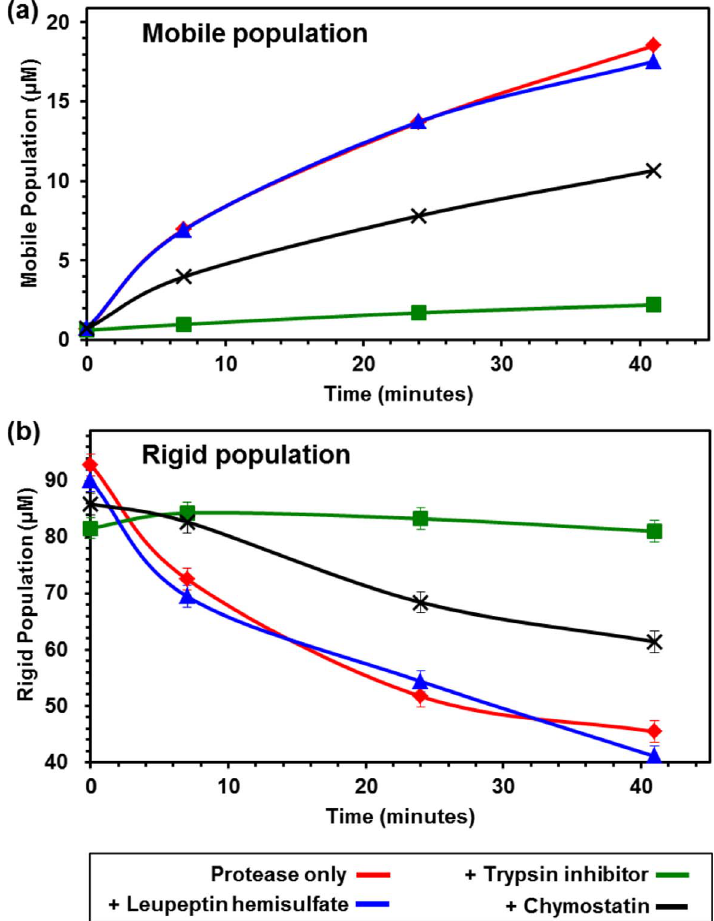
Figure 3. Increase in mobile population and near-symmetric decline in rigid population over a 41-minute time course. Data shown is that for digestion of HgA by a -chymotrypsin, alone or in the presence of three known protease inhibitors. Error bars for mobile population are too small to be visible at this